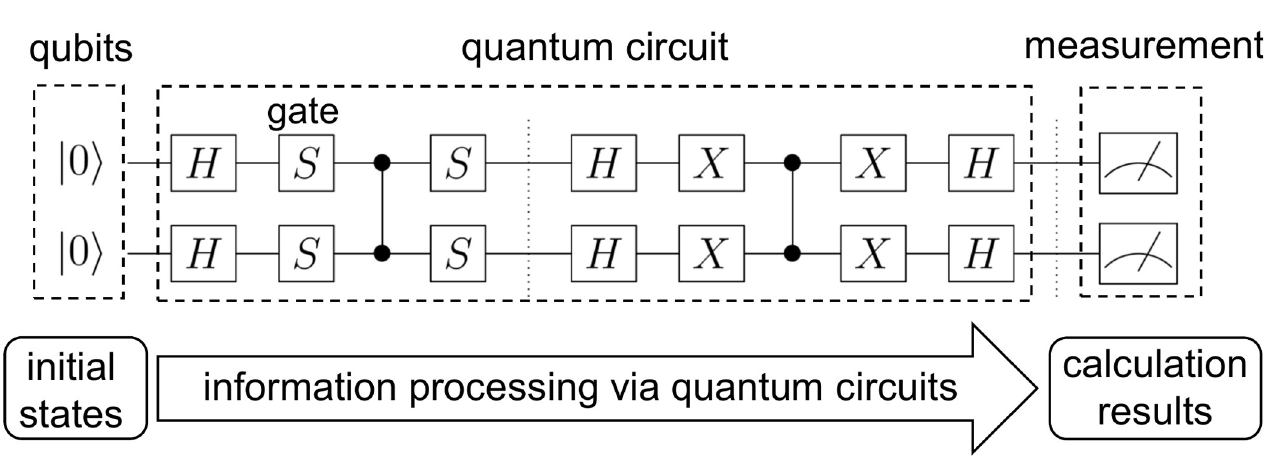
Fig 1. An example of quantum circuits. This shows a circuit that performs a quantum calculation called Grover’s algorithm. In quantum computation, qubits representing |0 i n as the initial states are prepared and passed through a quantum circuit to obtain the results. The wires mean that the quantum states are passed through as they are, and each gate marked with an alphabet changes the quantum state. The rightmost blocks with pictures of meters mean the measurement of the quantum state.